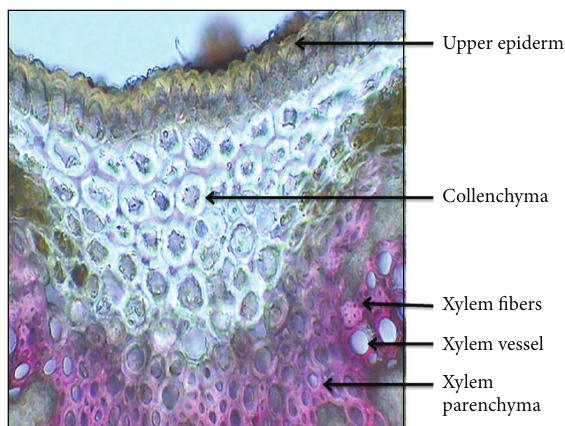
Figure 4: T.S. showing upper epidermis with collenchyma